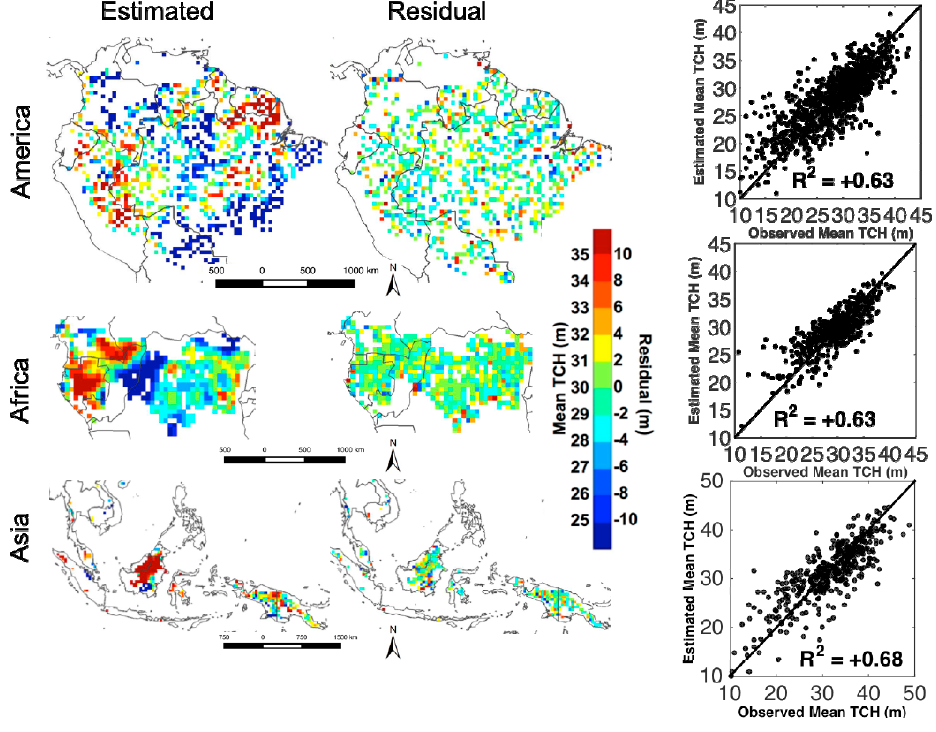
Figure 2. Spatial regression of tropical forests in America, Africa and Asia between TCH m and all the selected environmental variables.